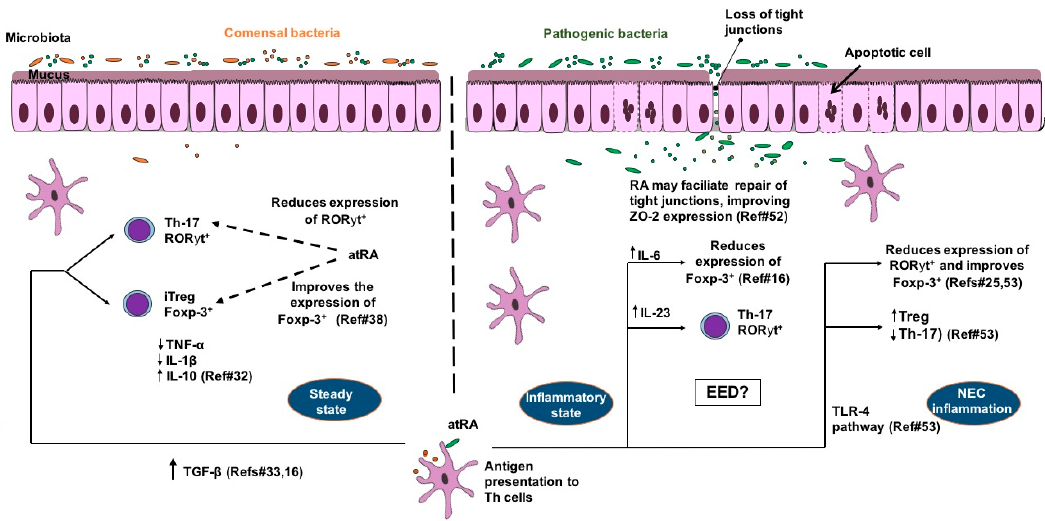
Figure 1. Model for the benefits of retinoic acid on intestinal barrier function in T-cell mediated inflammatory conditions such as environmental enteric dysfunction (EED) and neonatal necrotizing enterocolitis (NEC) in children. In steady state all-trans retinoic acid (RA) stimulates CD 103 + dendritic cells (DC) to produce more TGF- β , which favors Foxp-3 + T-reg differentiation rather than Th-17- retinoic acid receptor-related orphan receptor-gamma (ROR- γ t + ) cells. Foxp-3 + T-reg cells produce more anti-inflammatory cytokines (including IL-10) and less pro-inflammatory cytokines (TNF- α and IL-1 β ). In intestinal inflammation, RA is also important for Th17 ROR- γ t + for clearance of enteropathogens, with involvement of IL-6 and IL-23. In NEC inflammation, RA-TLR-4 pathway activation may reduce the expression of ROR- γ t + and favors Foxp-3 + differentiation rather than Th-17. RA may